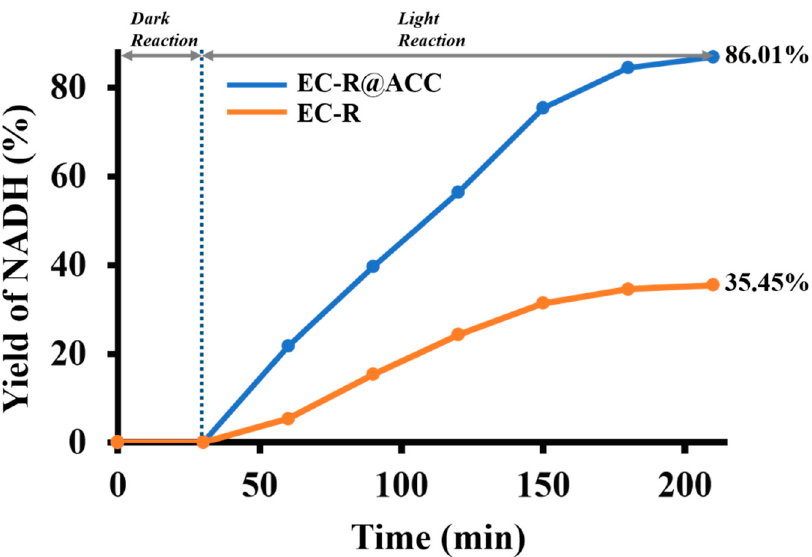
Figure 1. The photocatalytic activity of the EC-R@ACC photocatalyst and EC-R for NADH regener- ation under solar light.